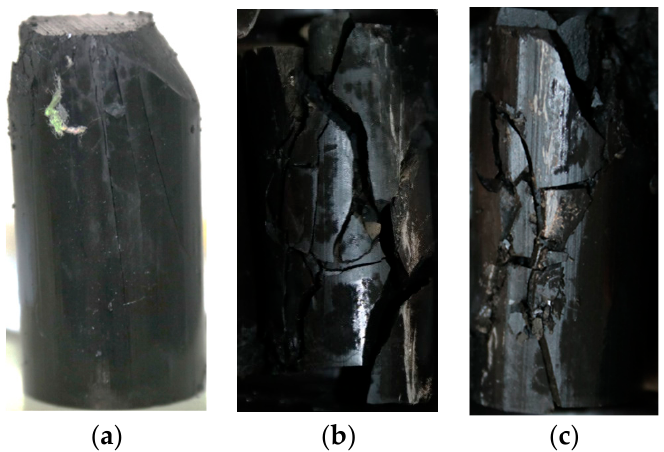
Figure 12. Damage diagram under a 0.5 MPa confining pressure: ( a ) moisture content: 0%; ( b ) moisture content: 1.06%; and ( c ) moisture content: 1.40%.